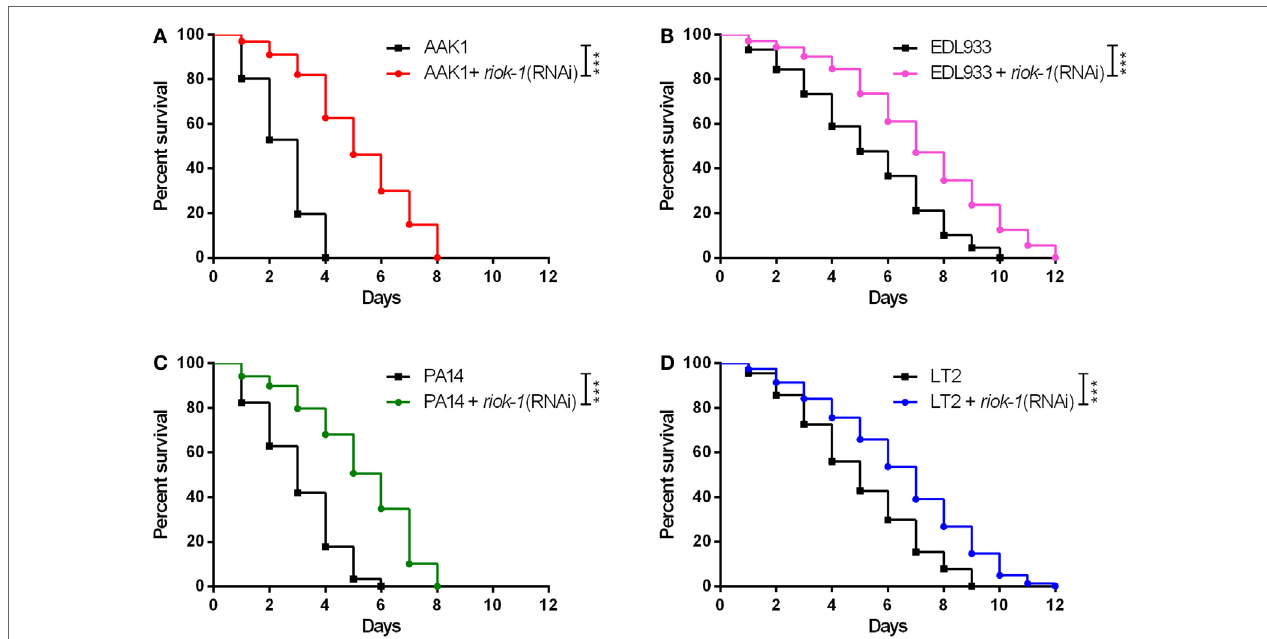
FigUre 6 | Suppressed expression of riok-1 increases the resistance to pathogens in Caenorhabditis elegans . Knockdown of riok-1 with RNAi in C. elegans confers resistance to (a) Aeromonas dhakensis AAK1, (B) enterohemorrhagic Escherichia coli EDL933, (c) Pseudomonas aeruginosa PA14, and (D) Salmonella typhimurium LT2. The statistical analyses of pathogens with and without riok-1 RNAi are all *** P < 0.001.